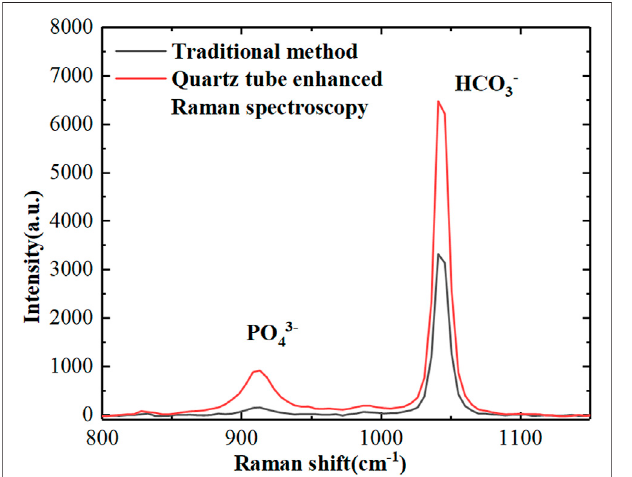
FIGURE 7 | Results comparison of quartz tube enhanced Raman spectroscopy and traditional Raman spectroscopy for powder samples with deep